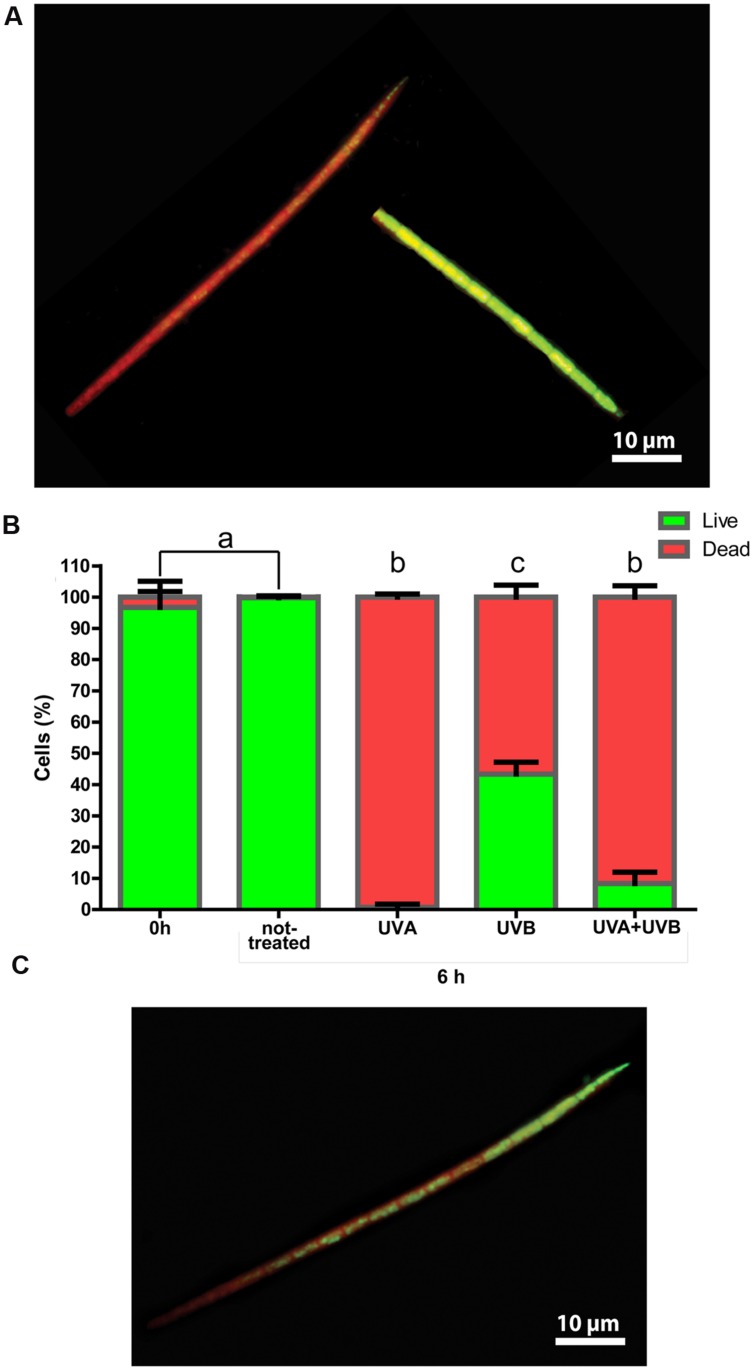
Cell viability of Cylindrospermopsis raciborskii exposed to UV radiation. In (A), live (green) and dead (red) cyanobacteria are observed. (B) After 6 h, all treatments induced significant cell death compared to untreated and 0 h groups (P < 0.0001 for all). Letters indicate a significant difference (P < 0.0001). In (C), both live and dead cells are seen on the same filament (after UVB treatment). Samples were stained with Syto 9 and propidium iodide (BacLight). Live and dead cells were viewed simultaneously, and 30 filaments/group were counted by fluorescence microscopy.